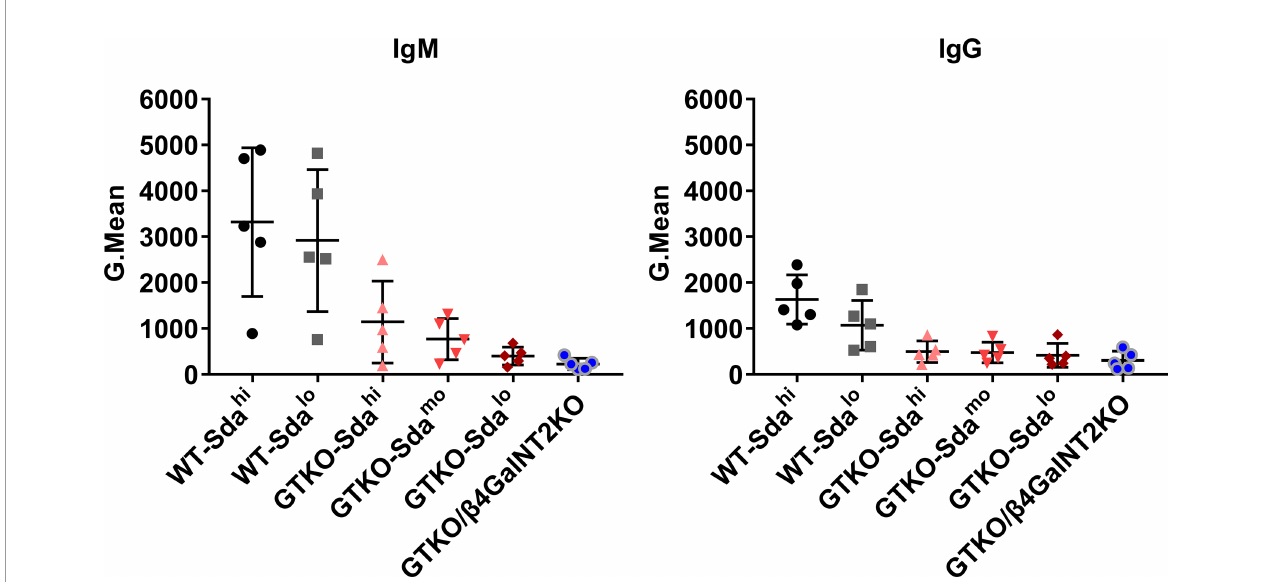
FIGURE 3 | Natural anti-pig antibody levels in the serum of rhesus monkeys. Five of 20 rhesus monkeys that had not been immunologically screened were randomly selected. Both anti-pig IgM and IgG levels in the serum (diluted at 1:10) of each monkey were measured by fl ow cytometry using PMBCs from WT (Sda hi and Sda lo ), GTKO (Sda hi , Sda mo , and Sda lo ) or GTKO/ b 4GalNT2KO pigs as the source of the target cells. The results are reported as Gmean. Data are presented as means ±